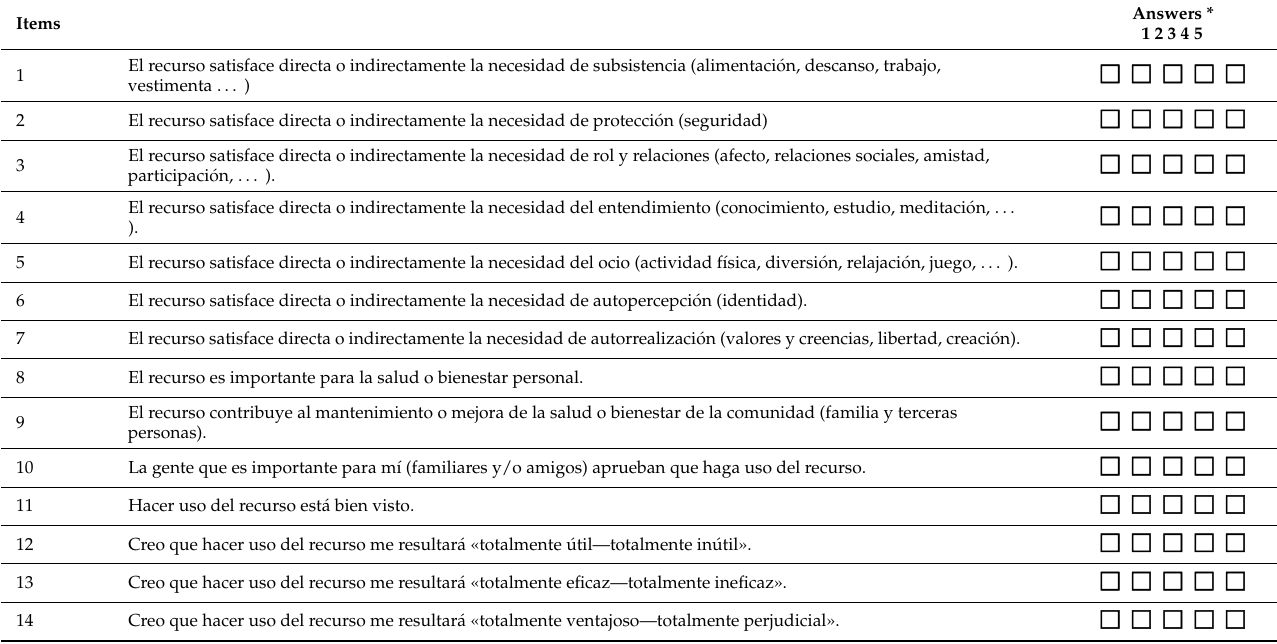
Table A1. Community assets for health assessment scale.